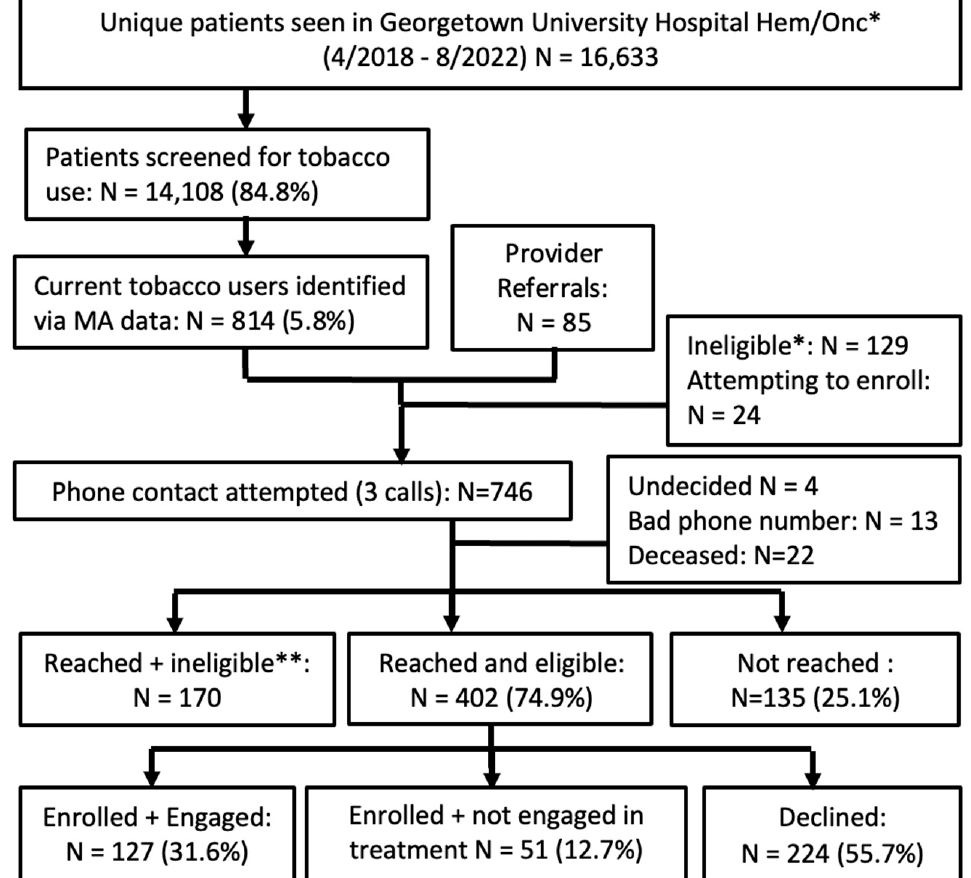
Figure 1. Georgetown University Hospital workflow and recruitment. * Excluding patients who